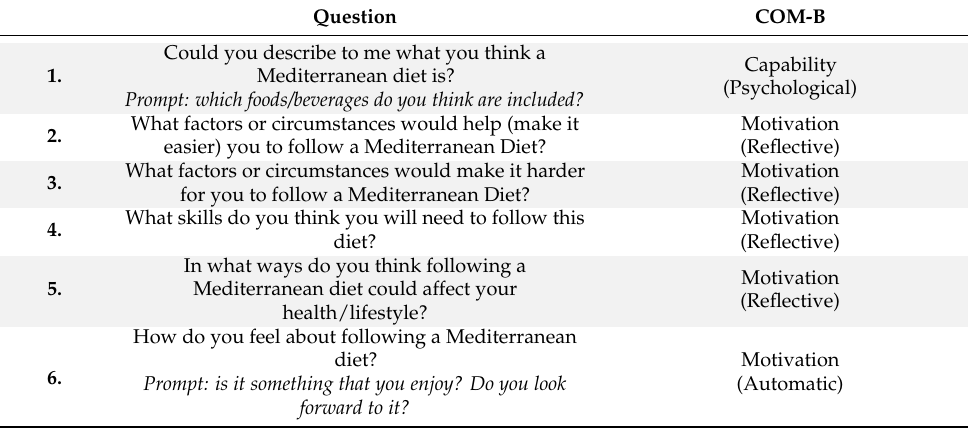
Table 4. Semi-structured interview questions to identify the feasibility of a MedDiet intervention.